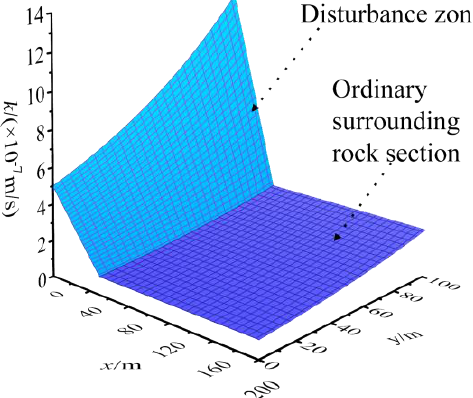
Figure 2. Spatial gradual change curve of permeability of surrounding rock.